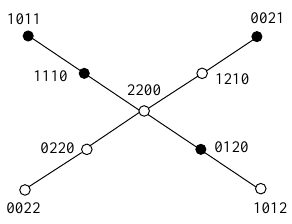
Figure 3: An ID-coloring of a twin-free starlike tree.